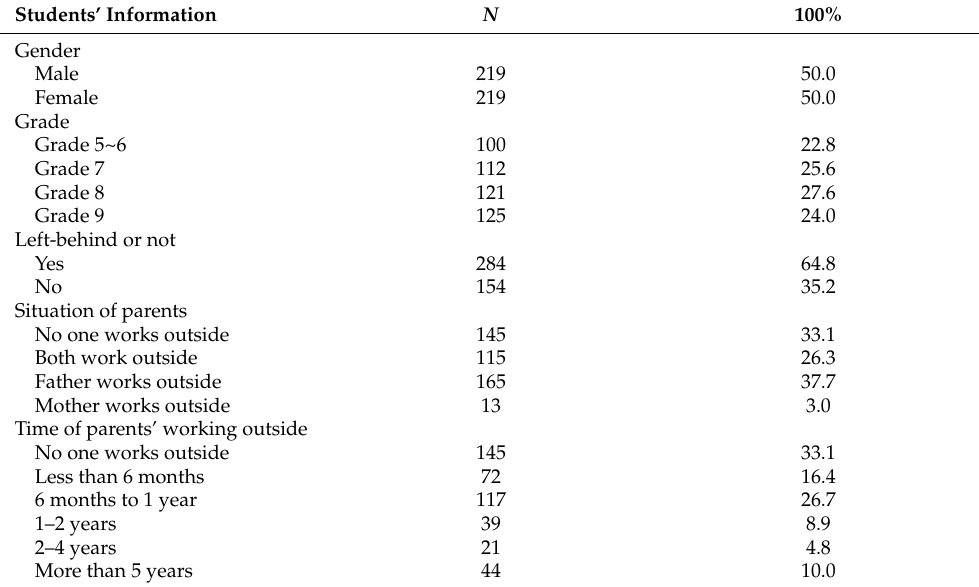
Table 1. Demographic information of the participants. ( N =